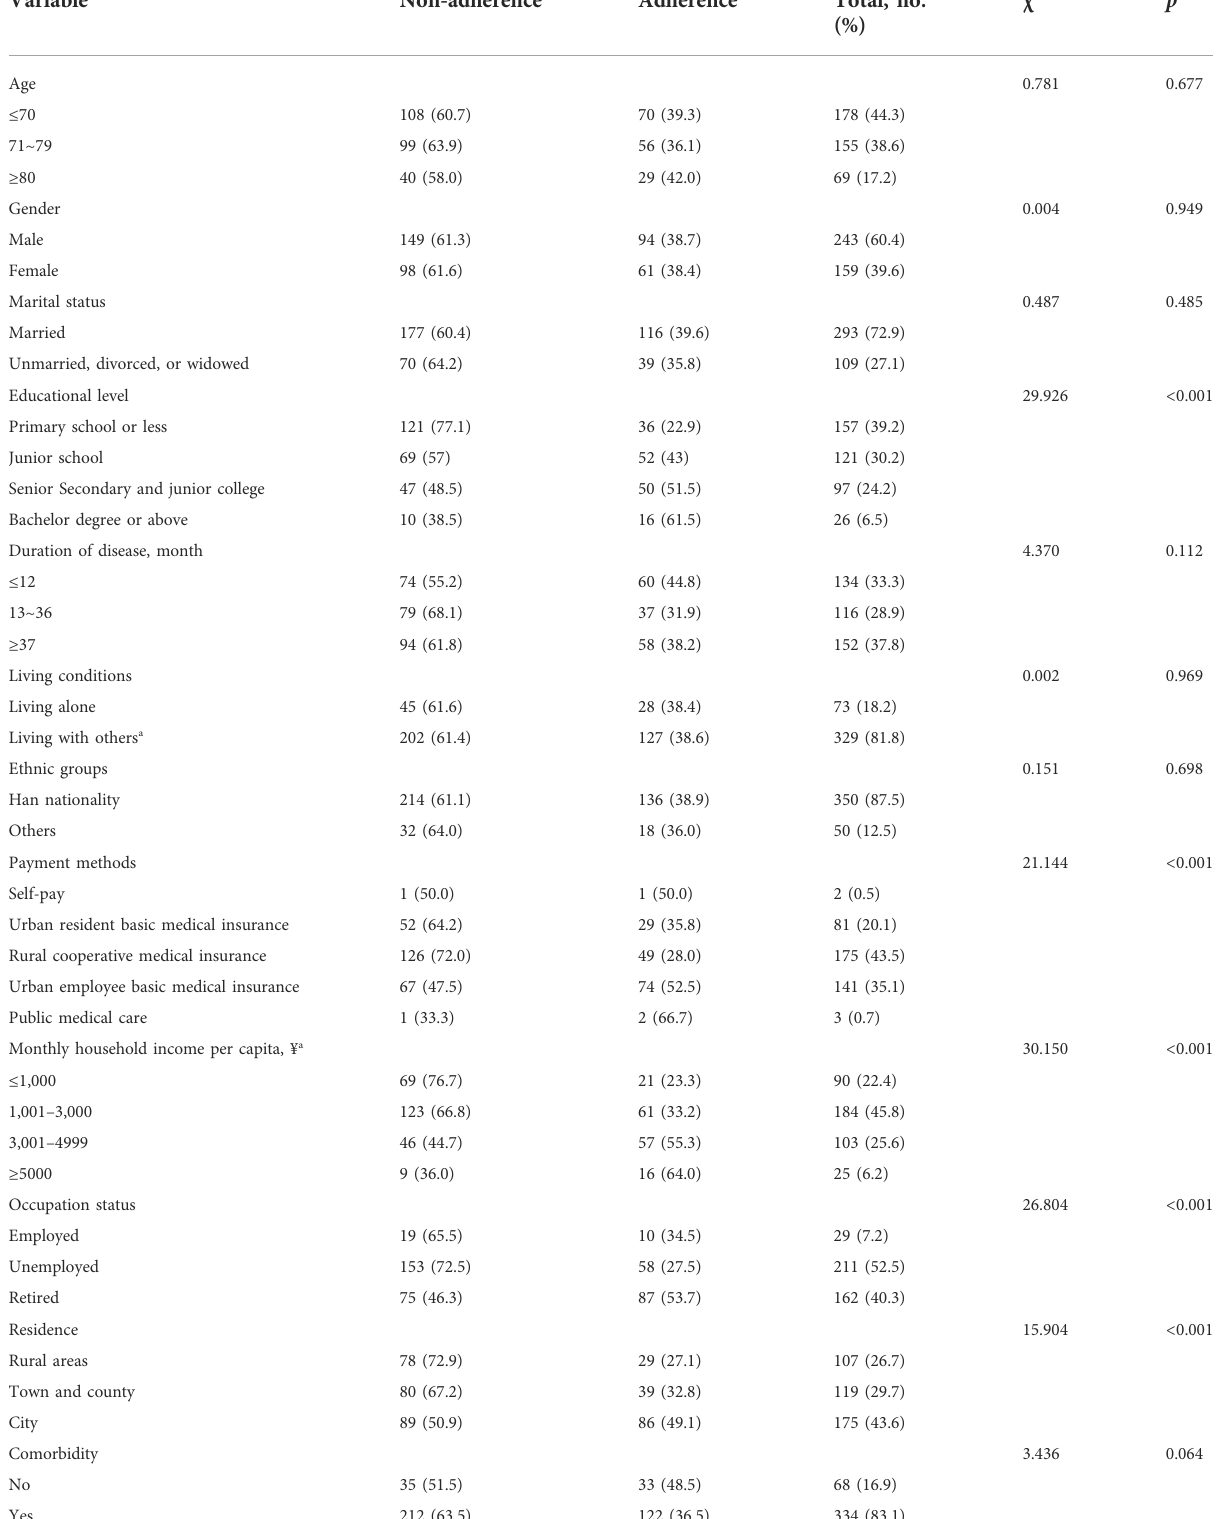
TABLE 3 Relationship of non-adherence with related